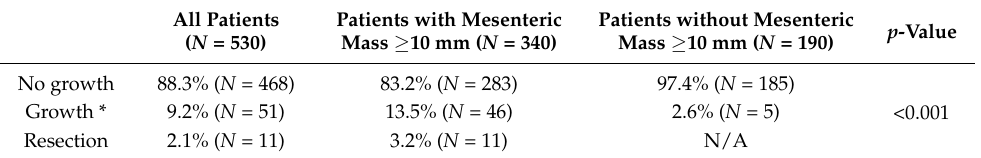
Table 2. Evolution of mesenteric mass over